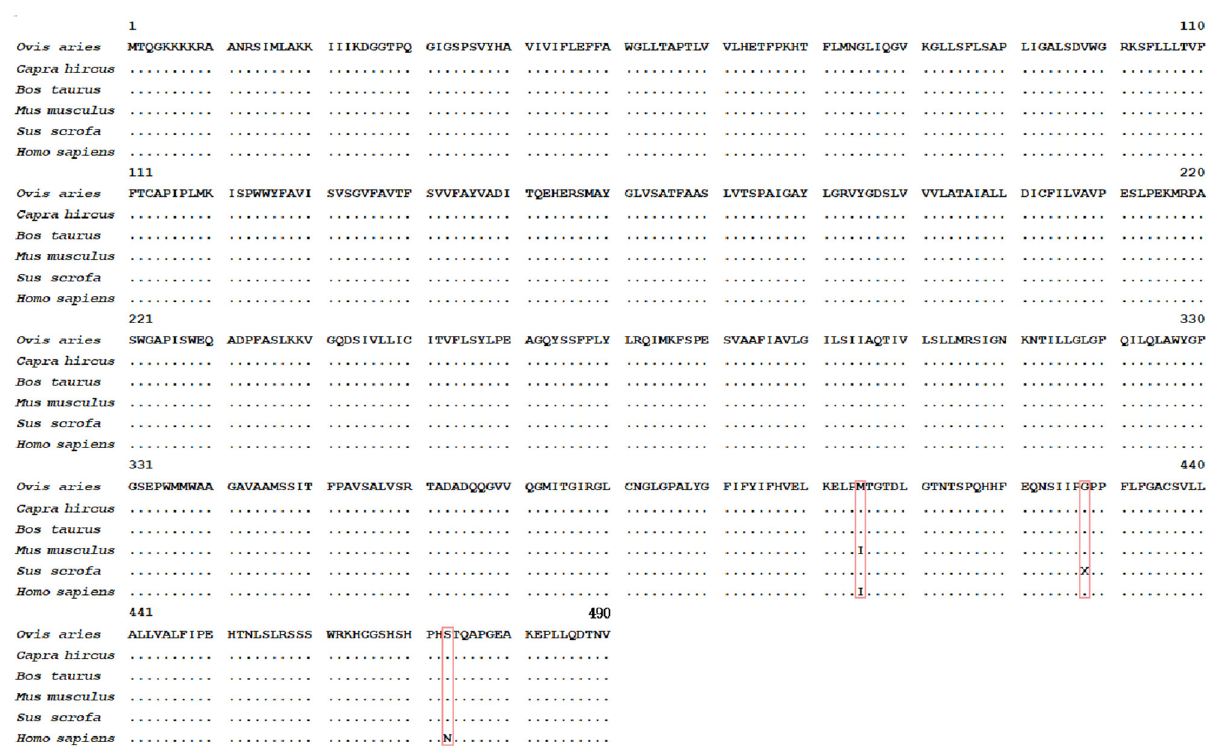
using Primer Premier 5 software and synthesized by Sangon Biotech (Xi’an, China) based on reference sequences in ovine HIAT1 (NC 056054.1). Polymorphic fragments were